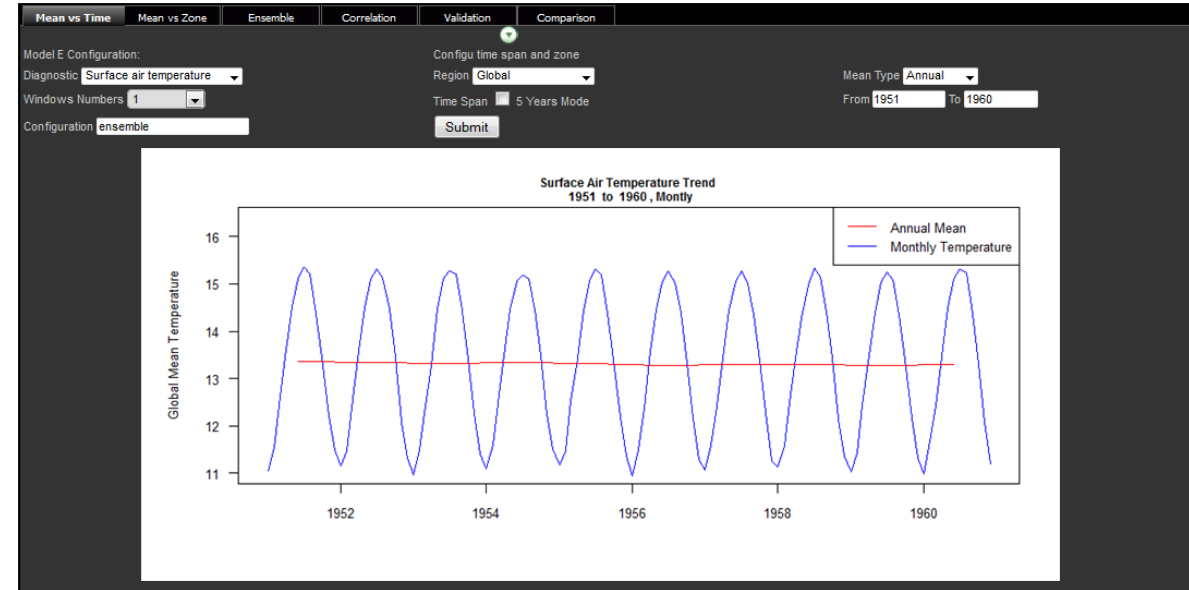
Figure 8. Interactive plot of mean values of a climate parameter vs. time using ensemble mean of surface air temperature as an